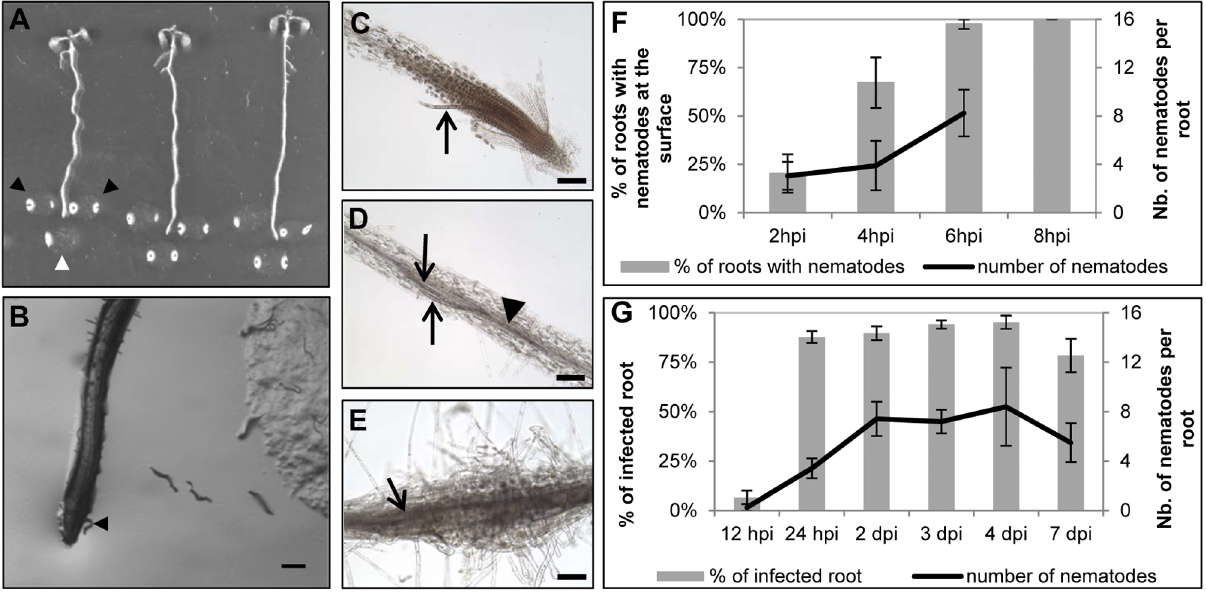
Figure 5. Assessment of the M.incognita - A.thaliana interaction prior to the root penetration. A , in vitro inoculation of A. thaliana root tips with M. incognita infective juveniles in 0.1% agarose (arrowhead) in 3 inoculation points around the root tip. At 8 hours post-inoculation (hpi), the root tip reached the bottom point inoculation (white arrowhead) B , Nematode (arrowhead) at the surface of the root tip at 4 hpi, bar=200 m m. C and D , Nematodes start to penetrate (arrows) from 12 hpi to 2 days post-inoculation (dpi), while some nematodes could be observed in the vascular cylinder from 2 dpi (arrowhead in D ). E , Initiation of nematode feeding site could be observed at 4 dpi in close proximity to the nematode’ head (arrow), bars=100 m m, F , Percentage of roots with nematodes at their surface (grey columns) and number of nematodes present at the root surface (black lines) from 2 to 8 hpi. G , Percentage of infected roots (grey columns) and number of nematodes per root (black lines) during penetration, from 12 hpi to 2 dpi and post-penetration, from 2 dpi to 7 dpi.